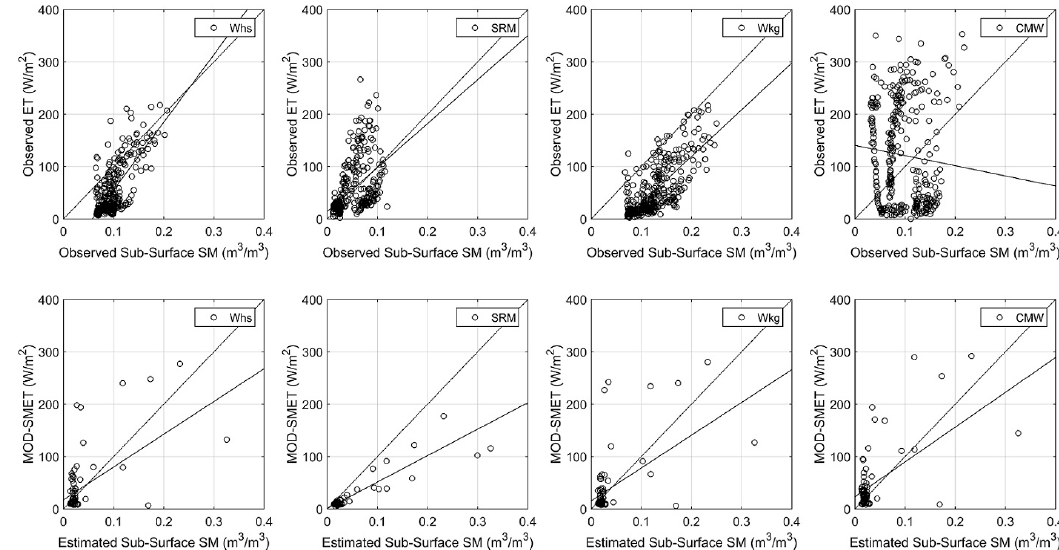
Figure 4. ( Top Row ) Comparison between observed sub-surface soil moisture (m3/m3) and observed ET (W/m 2 ) at sites Whs, SRM, Wkg, and CMW for year 2013. ( Bottom Row ) Comparison between modeled subsurface soil moisture and MOD-SMET ET estimates at sites Whs, SRM, Wkg, and CMW for year 2013.